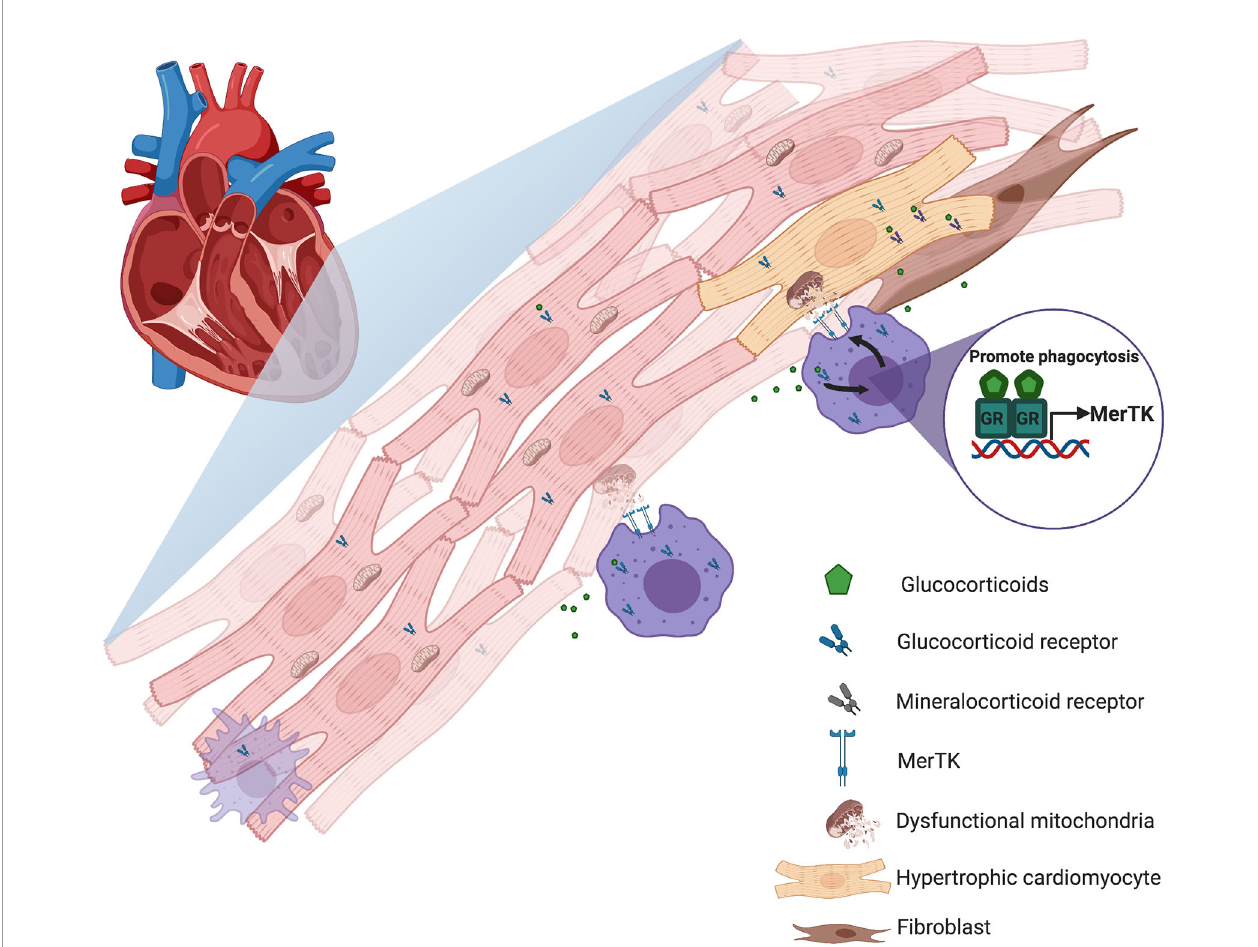
FIGURE 1 | Schematic representation of how glucocorticoids could contribute to cardiac tissue homeostasis. Upon damage or stress activation, glucocorticoid- activated cardiac macrophages promote the active elimination of hypertrophic cardiomyocyte-derived mitochondria and help maintain cardiac health and homeostasis through the induction of the phagocytic receptor Mer tyrosine kinase